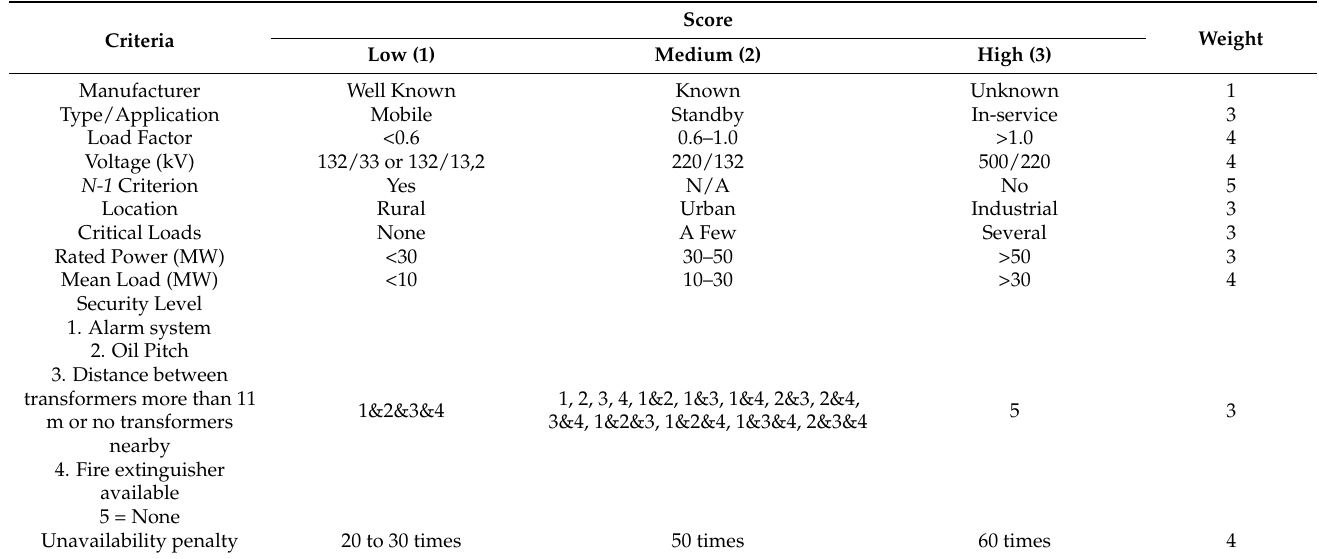
Table 1. Criteria and score for the II